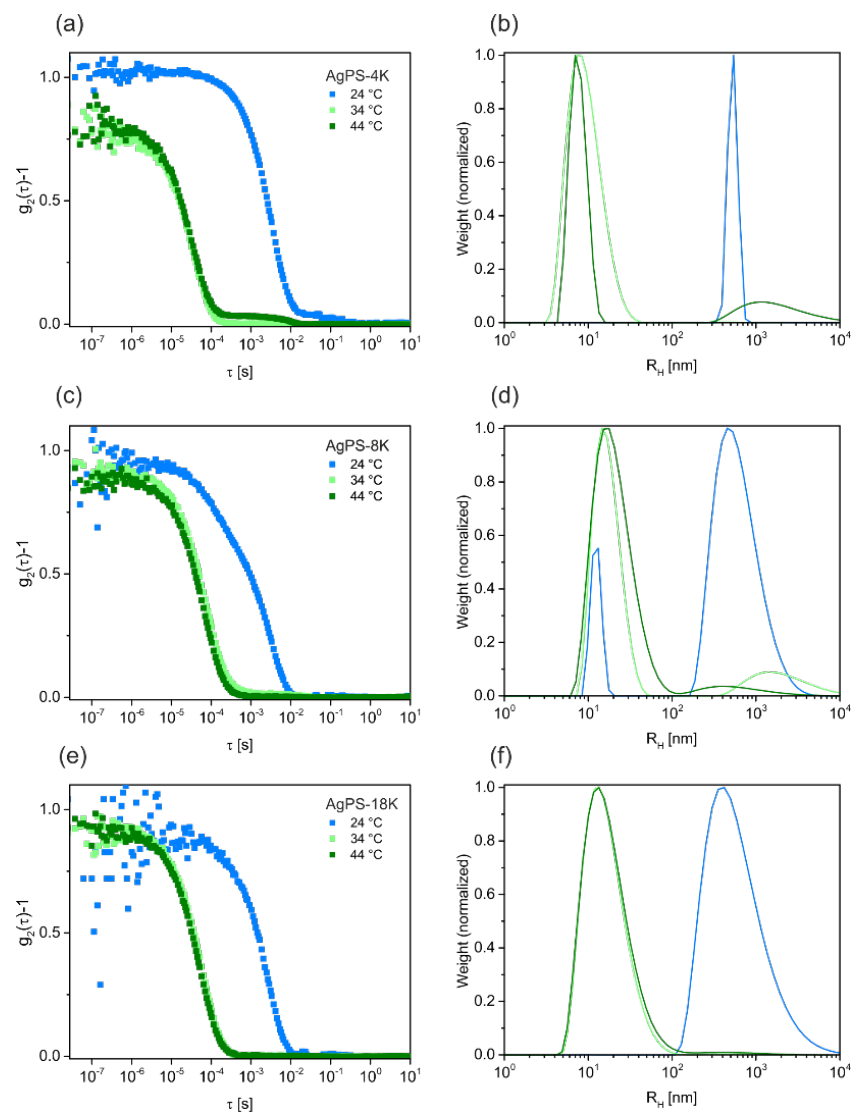
Figure 3. Dynamic light scattering measurements of PNCs in cyclohexane. Left panel: intensity-time autocorrelation functions. Right panel: corresponding size distribution of the samples obtained from CONTIN analysis. The measurements were performed at three different temperatures. Below (24 °C), at (34 °C) and above (44 °C) the Θ-temperature. The ligand length increases from top to botton: ( a , b ) AgPS-4K sample, ( c , d ) AgPS-8K sample and ( e , f ) AgPS18K sample. All samples show aggregates below the Θ-temperature.